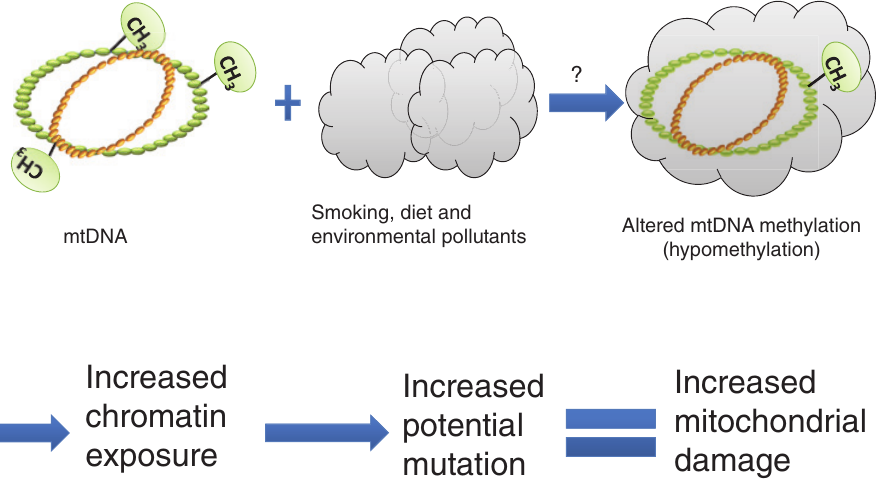
Figure 1: The effect of environmental factors like smoking. Environmental factors like smoking, diet and pollutants alter the mtDNA methylation pattern leading to increased chromatin exposure, increase potential mutation and eventually mitochondrial